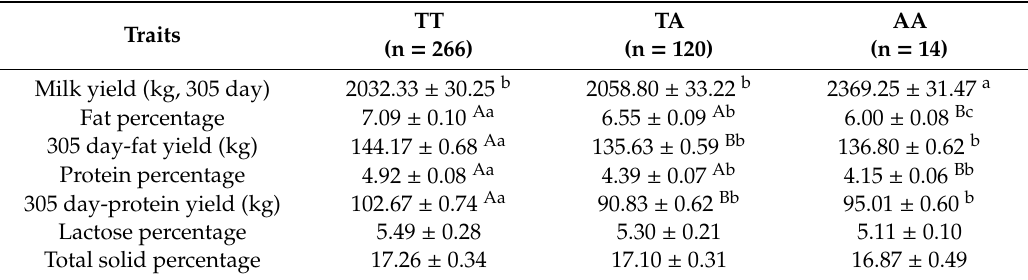
Table 4. Association of individual c.836T > A SNP with milk yield and quality traits.